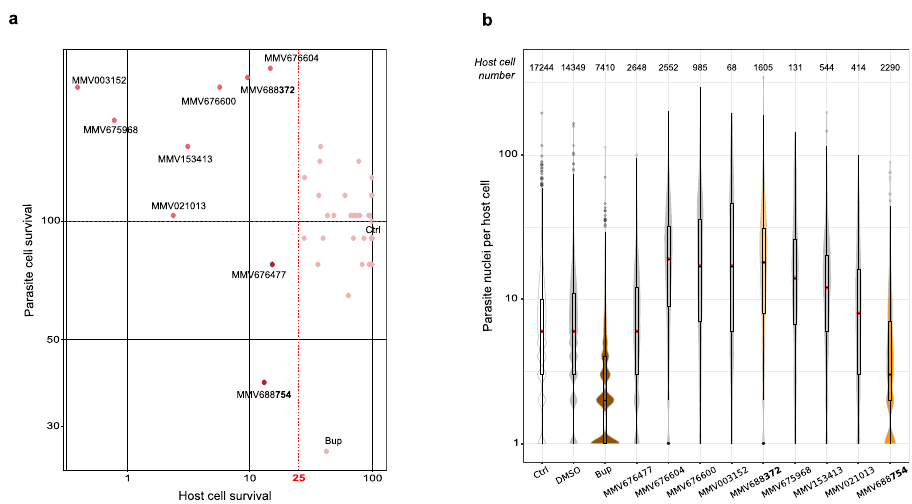
Fig. 2 Screening for impact on parasite and host cell survival. a Bi-parametric dot plots showing the host cell and parasite survival as a percentage of DMSO-treated controls. Only two MMV compounds decreased host and parasite cell survival effectively, while the other 7 caused increased parasite numbers. This is probably due to the stress caused by drug cytotoxicity of host cells and the impact on parasites in the remaining surviving cells. The DMSO control (Ctrl) and Buparvaquone (Bup) data are shown for comparison. b Violin plots of the number of parasites per host cell. Data are shown for untreated, DMSO-treated, buparvaquone (Bup)-treated and hit compound-treated samples. Only one drug (MMV688754) showed a strong decrease in parasite number comparable to Buparvaquone treatment. The relative surviving host cell numbers are indicated above. The red dot represents the median number of parasites per surviving host cell, the boxplot shows the 1st and 3rd quartiles. The Buparvaquone drug is shown in brown and the two compounds MMV688372 and MMV688754 used in subsequent experiments are colored